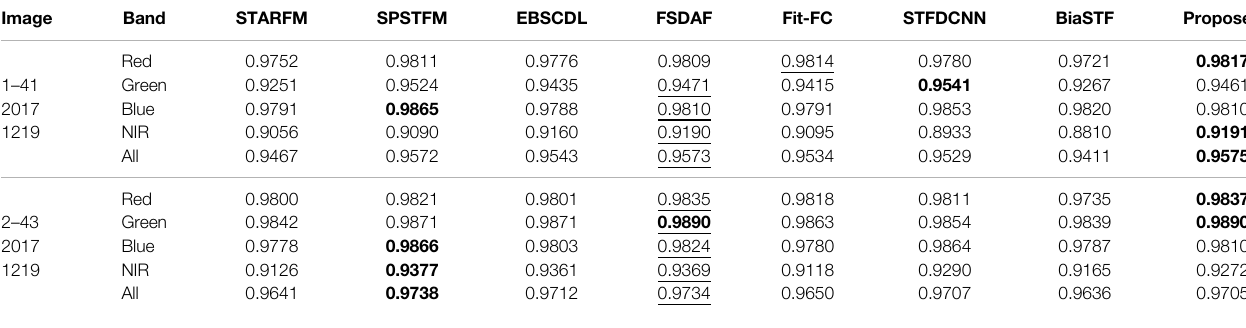
TABLE 6 | SSIM evaluation of radiometric error for the Landsat-8